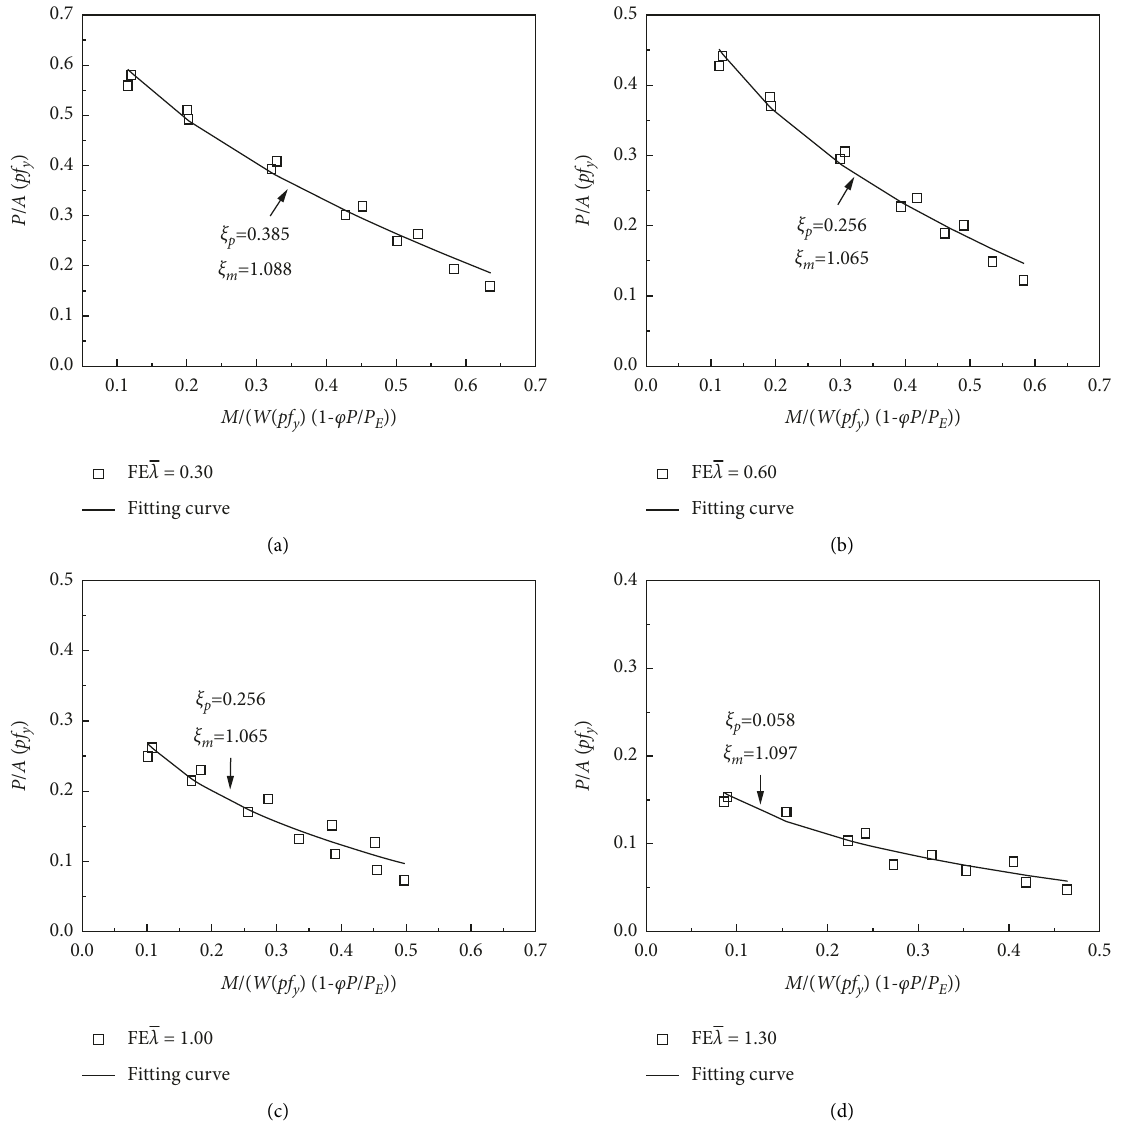
(cid:31)(cid:31) λ 0 . 3, (b) (cid:28)